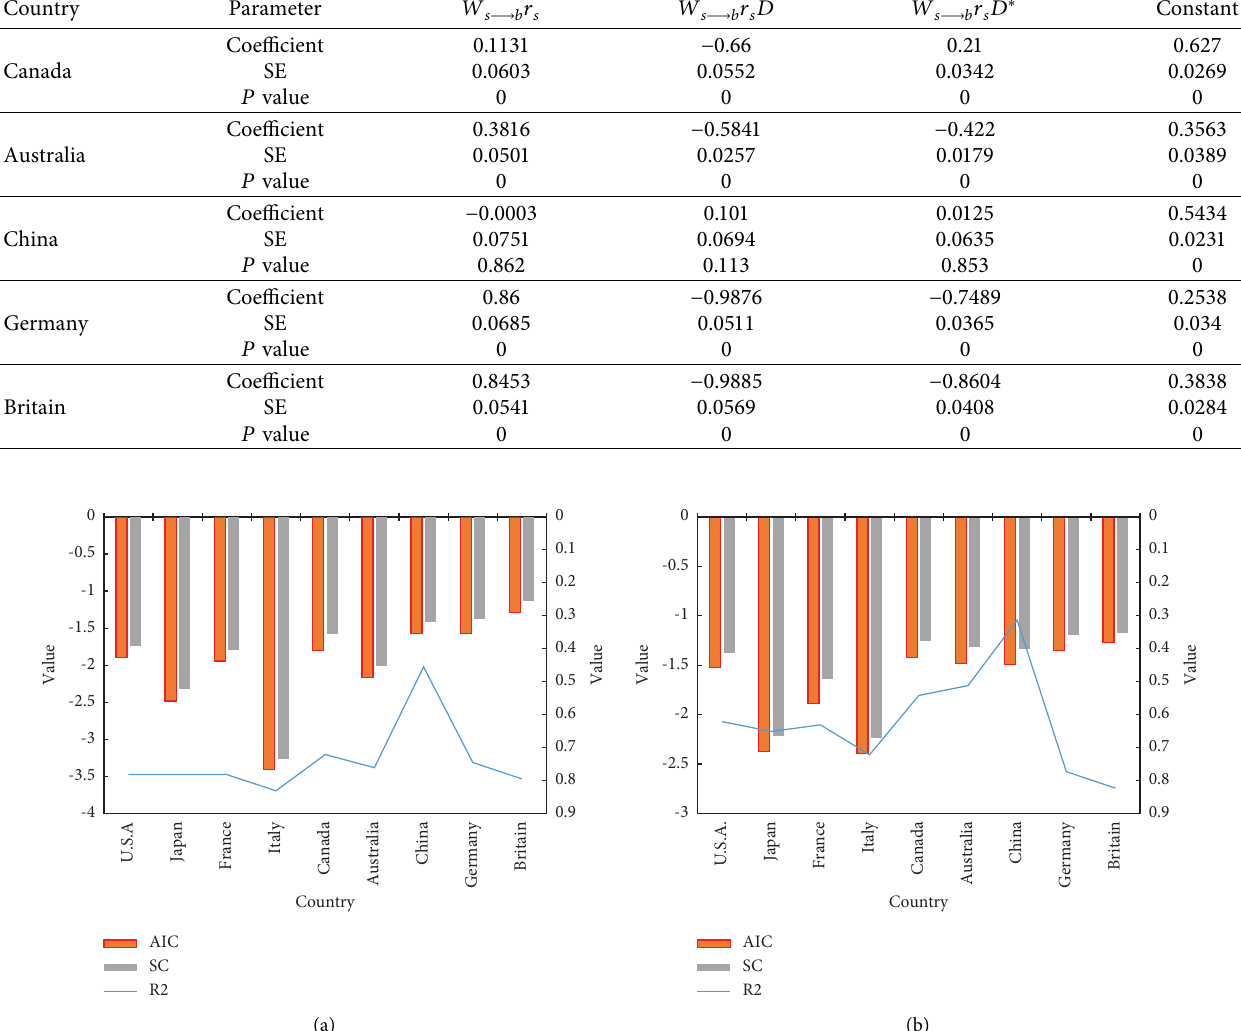
Table 2: Five other countries transfer entropy GARCH (1,1) models mean equation estimation results.